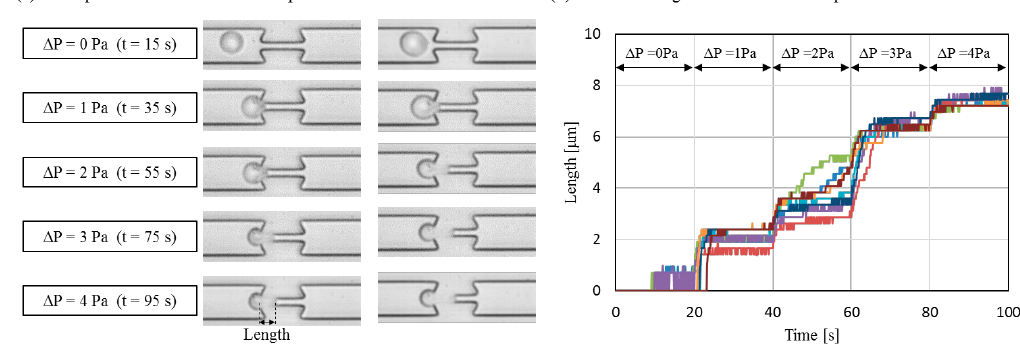
Figure 10. Applications on precise cell evaluation by pressure increments. ( a ) Two examples of RBC deformation under different amounts of applied pressures; ( b ) Tracked insertion length.